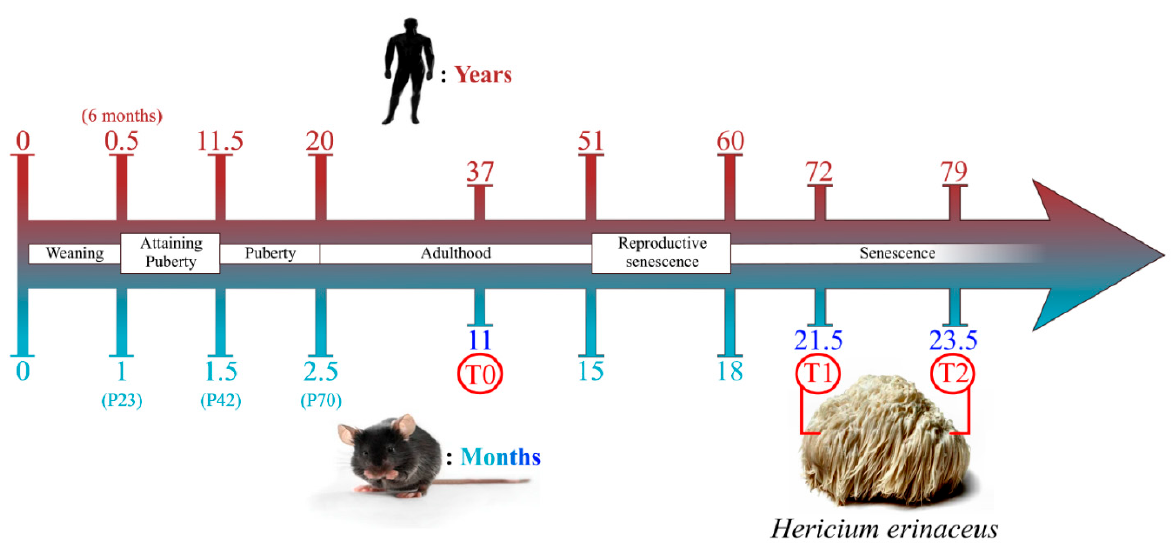
Figure 16. Schematic drawing summarizing experimental time course, chosen timepoints and comparison between men and mice age during their life span (modified from [14]).